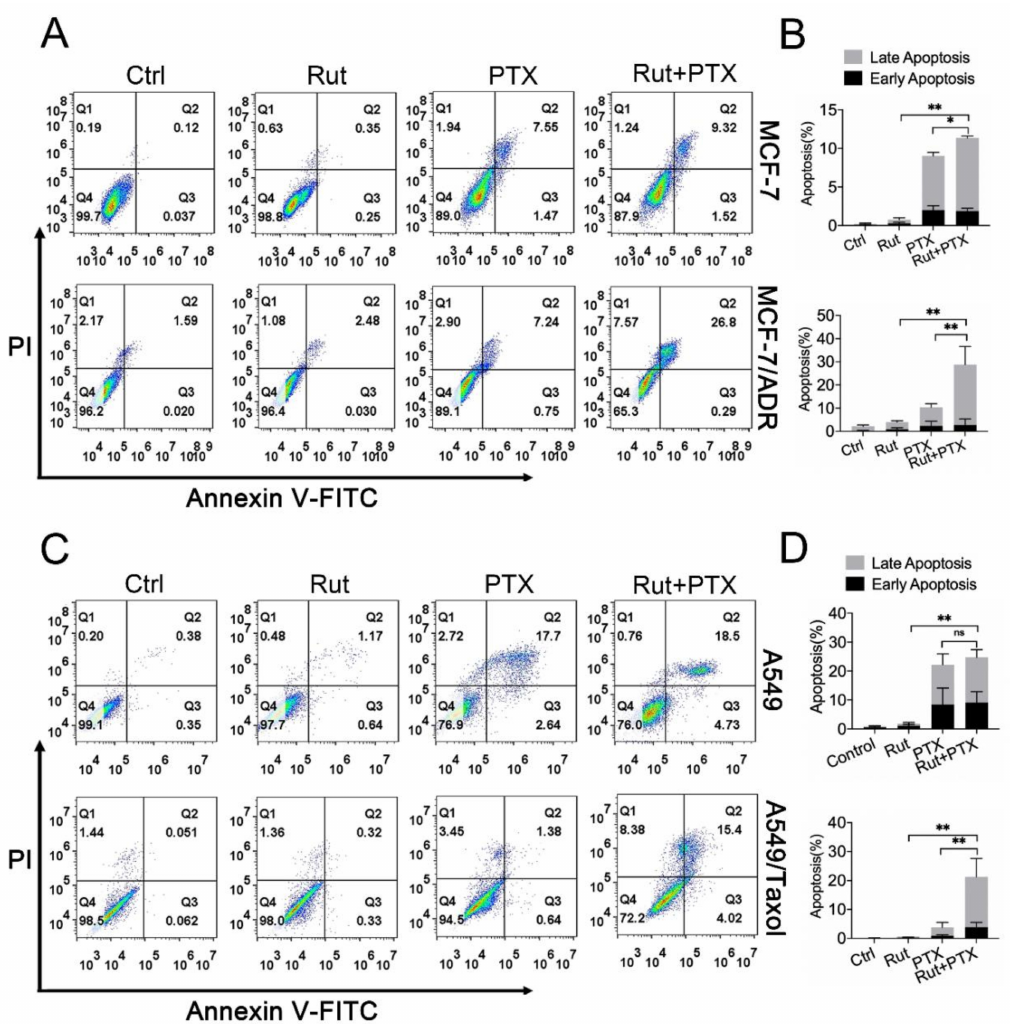
Figure 4. The effects of rutaecarpine combined with anticancer drugs on the apoptosis of parental and ABCB1-overexpressing cells. ( A – D ) The apoptosis was detected by FCM with Annexin V/PI staining and the percentage of apoptotic cells was analyzed. Various treatments were given as follows: MCF-7 and A549 cells were treated with 20 µ M rutaecarpine, 500 nM paclitaxel alone or in combination for 48 h. MCF-7/ADR and A549/Taxol cells were treated with 20 µ M rutaecarpine and 5 µ M paclitaxel alone or in combination for 48 h. Rut, rutaecarpine; ADM, adriamycin; PTX, paclitaxel. Data are presented as mean SD of three independent experiments, * p < 0.05 and ** p < ±